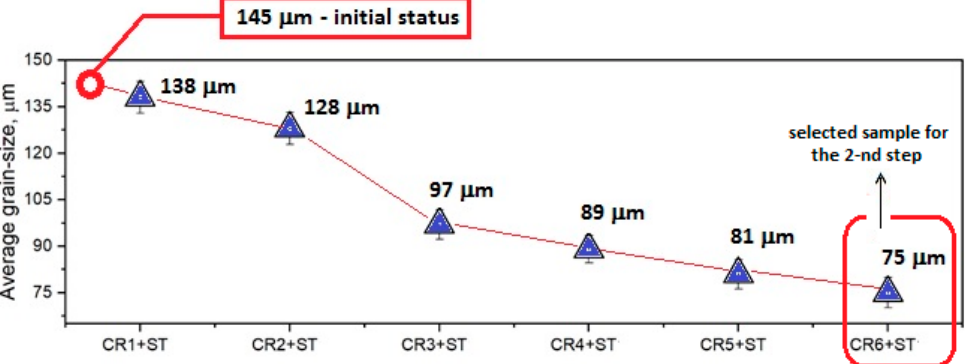
Figure 7. The evolution of the β grain average dimension as a function of the applied TMP variant corresponding to the 1st step of the 1st direction of the TMP Program.